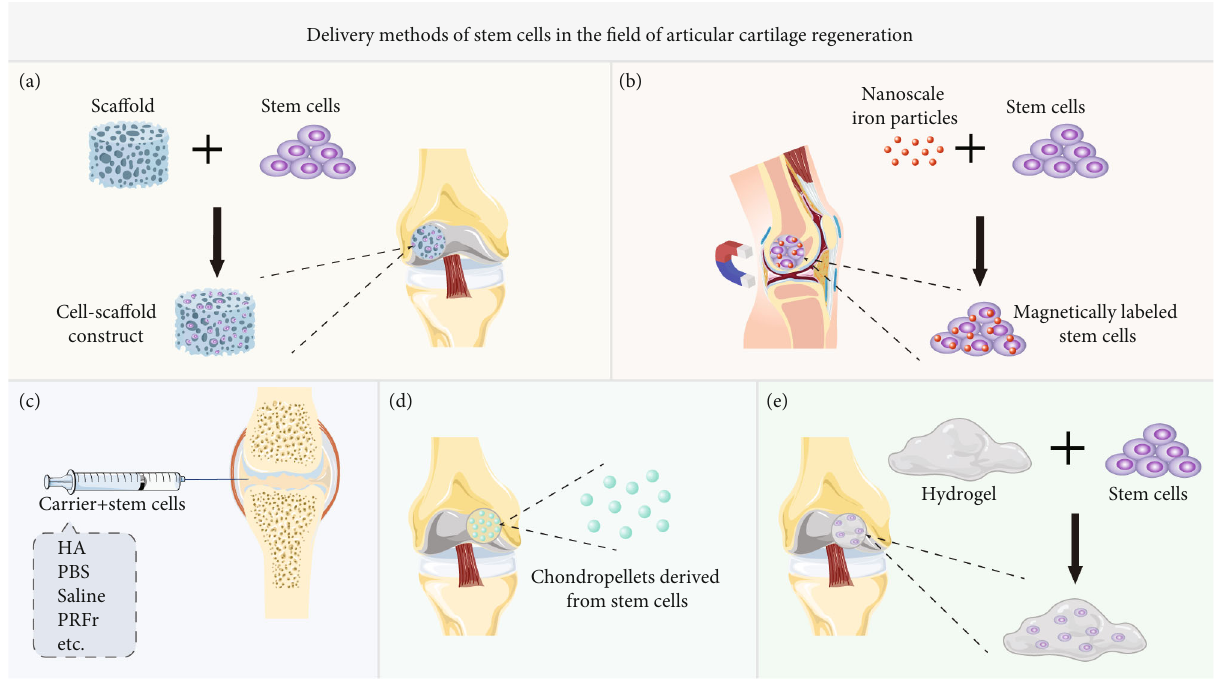
Figure 2: Stem cell delivery for repairing articular cartilage defects or treating OA. (a) Cell-sca ff old construct. Stem cells are planted on a tissue engineering sca ff old, cultured in vitro until the cells adhere to the sca ff old, and then, the cell-sca ff old construct is implanted into the cartilage defect. (b) Magnetic targeting. Place a magnet on the back of the cartilage defect (popliteal fossa), use nanoiron particles to label stem cells, and then implant the stem cells into the cartilage defect. Under the attraction of the magnet, the stem cells are tightly fi xed to the bottom of the cartilage defect. (c) Intra-articular injection. The stem cells are resuspended in hyaluronic acid (HA), phosphate- bu ff ered saline (PBS), physiological saline or platelet-rich fi brin releasate (PRFr), and other carriers and then injected into the joint cavity. (d) Chondrocyte pellets. The stem cells are cultured and di ff erentiated in vitro to form cartilage pellets, and then, the cartilage pellets are implanted into the cartilage defect. (e) Cell-hydrogel construct. The stem cells are mixed into the injectable hydrogel material, and then, the cell-hydrogel construct is injected into the cartilage